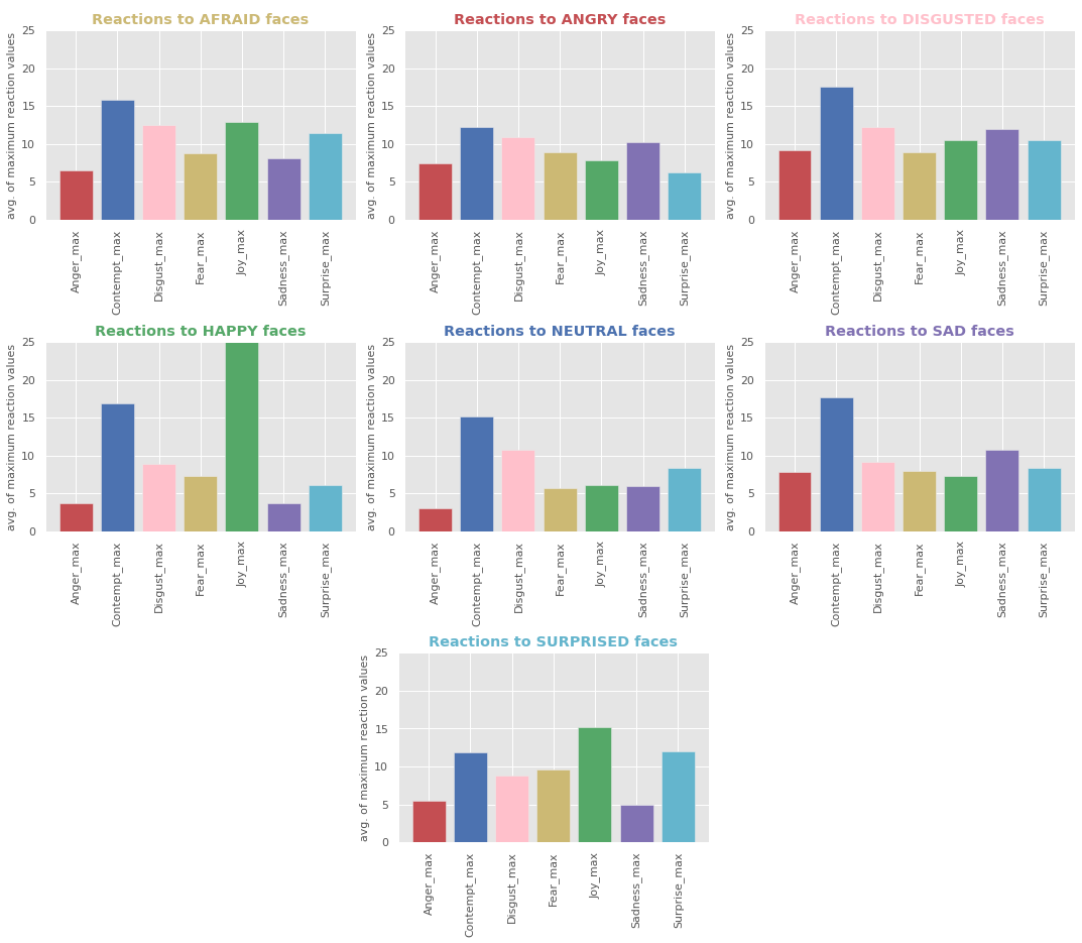
Figure 7. Facial reactions vs. stimuli bar plots generated by taking the average of the maximum values for each reaction and stimulus across all subjects. Each plot represents the data for one type of emotional stimuli, with x-axis representing the types of reaction and y-axis representing the average of the maximum reaction probability